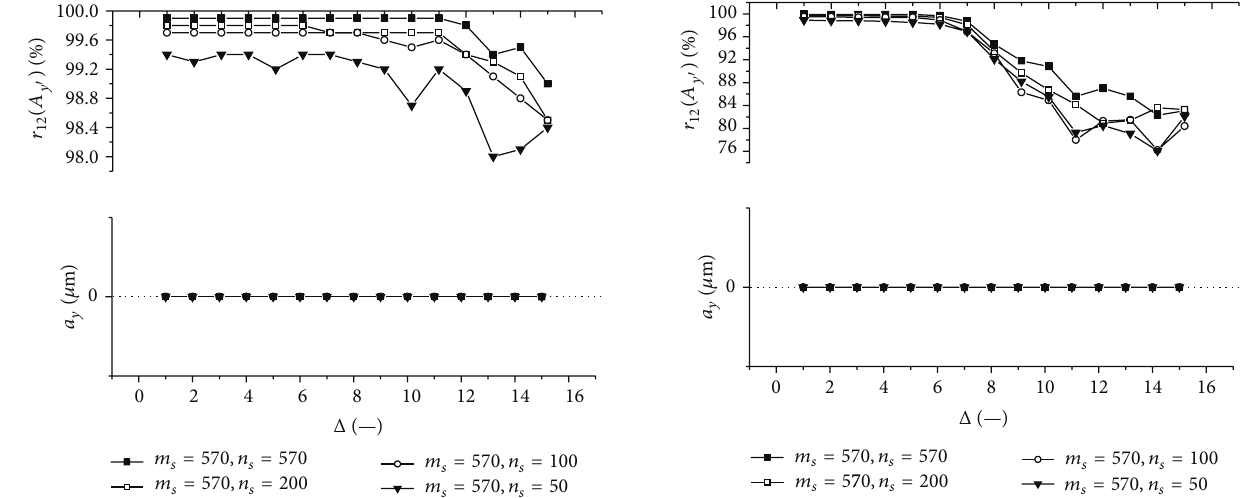
Figure 15: The evaluated object’s translation component 𝑎 𝑦 as well as the maximum 𝑟 12 (𝐴 𝑦 󸀠 ) of the 1D normalized cross-correlation function of intensity signals 𝐼 1 and 𝐼 2 acquired from decimated 2D intensity signals of various size as a function of the factor Δ . Mean speckle sizes are 𝛼 𝑥 󸀠 = 264.9 𝜇 m and 𝛼 𝑦 󸀠 = 225.5 𝜇 m. The object is translated by 𝑎 𝑥 = 10 𝜇 m and 𝑎 𝑦 = 0 𝜇 m.